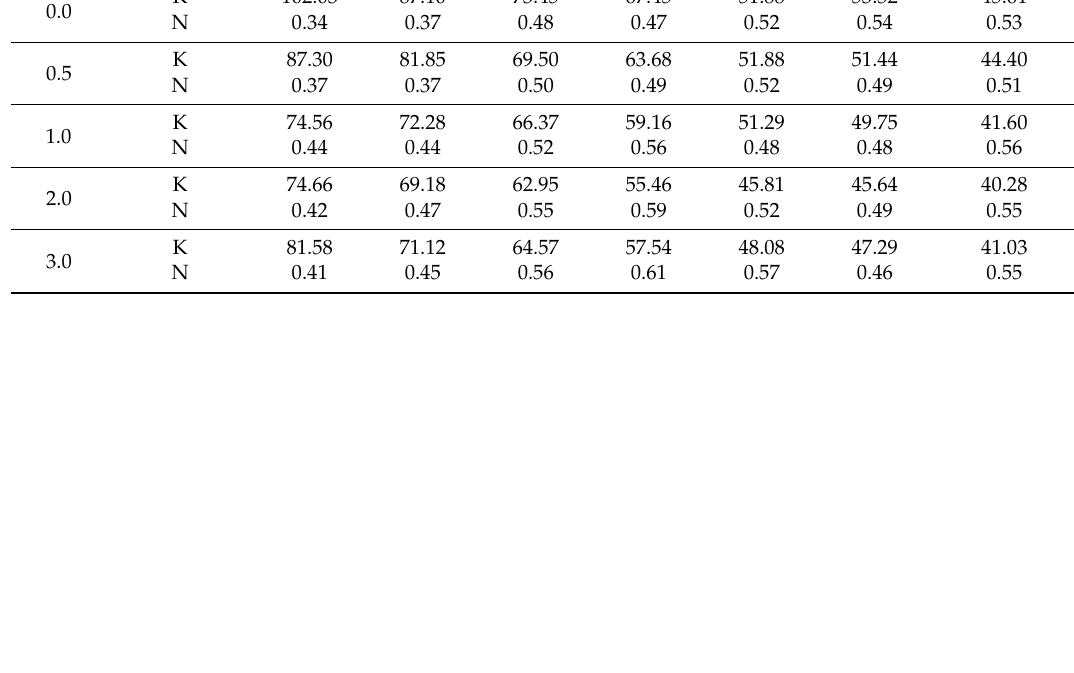
Table 9. Values of material constants K and N.